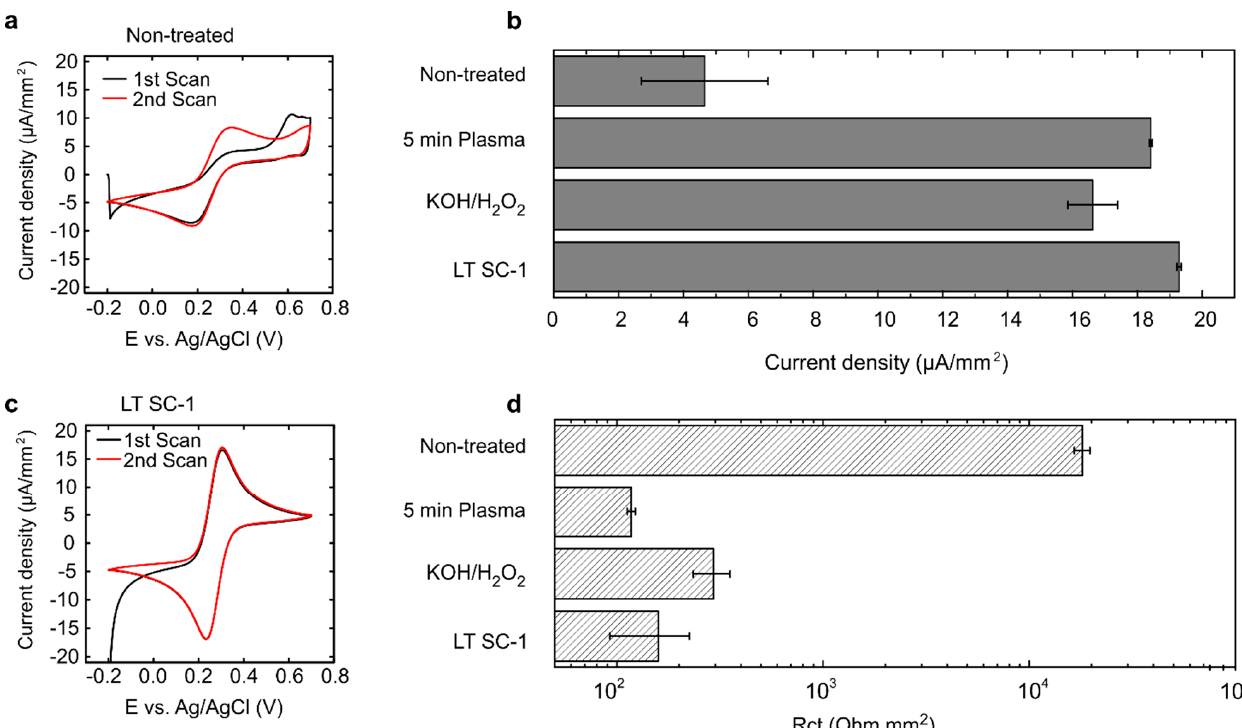
Figure 1. The effect of cleaning on electrode performance. ( a ) CVs in ferri-/ferrocyanide solution with non-treated PCB. ( b ) Comparison of current density obtained using CV in ferri-/ferrocyanide solution using multiple cleaning techniques by determining oxidation peak height. ( c ) CV in ferri-/ferrocyanide solution with PCB that underwent LT SC-1 cleaning treatment. ( d ) Comparison of Rct obtained using EIS in ferri-/ferrocyanide solution using multiple cleaning techniques. Bars represent the mean and error bars represent the SD, N = 4 in ( b ) and ( d ).